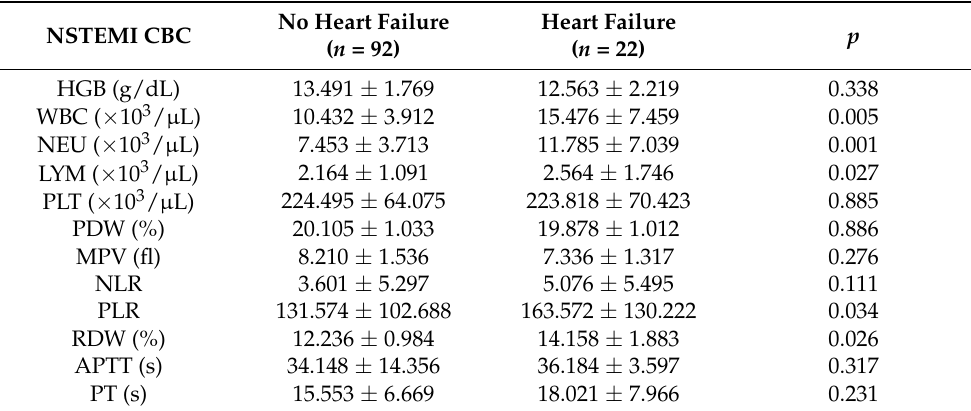
Table 12. Hematological and coagulation parameters of the groups with/without heart failure in NSTEMI